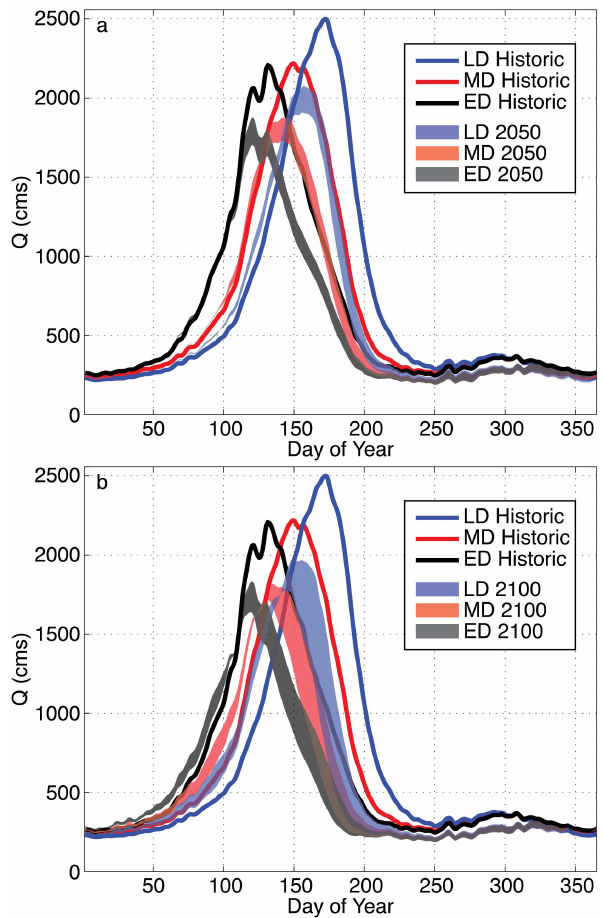
Fig. 8. (a) Mean annual hydrograph at Lees Ferry, showing moder- ate dust (MD), low dust (LD), and extreme dust (ED) historic traces and mean annual hydrograph for all three dust/albedo scenarios, for decade centered on 2050; colored areas show the range in hydro- graph response between B1 and A2 emissions scenarios; and (b) as in (a) , but for the decade ending